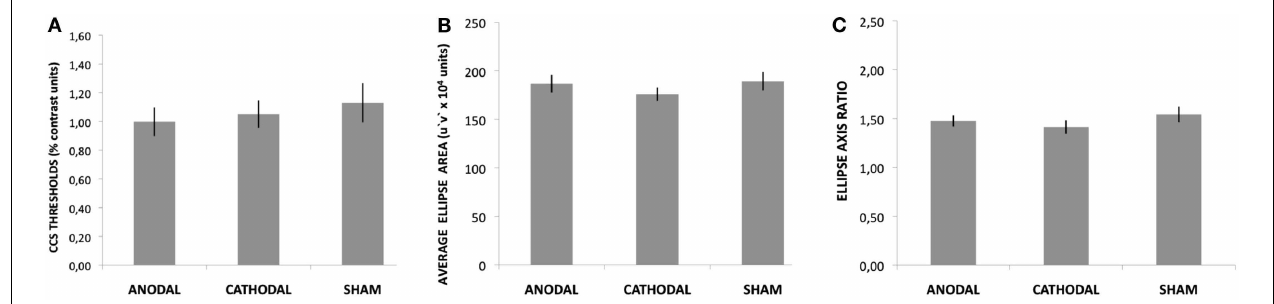
red-green thresholds measured with the CCS task. (B) Average ellipse area measured with the CCT ellipses test. (C) Average ellipse axis ratio measured with the CCT ellipses test.